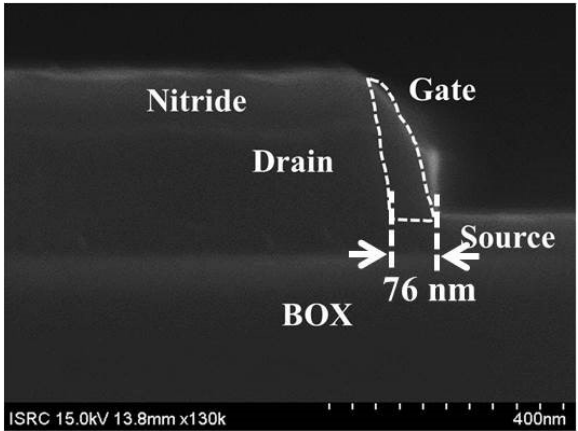
Figure 6. Cross-sectional SEM image which demonstrates raised drain and sidewall gate structure.